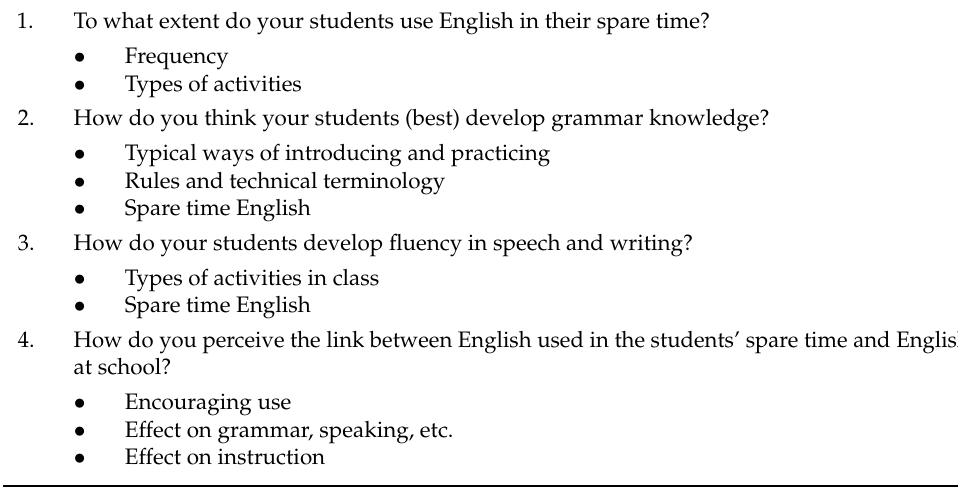
Table 2. Outline of the teacher